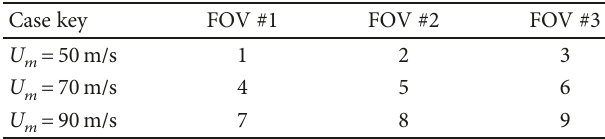
Table 2: Key of the nine di ff erent experimental cases. U the airfoil velocity.